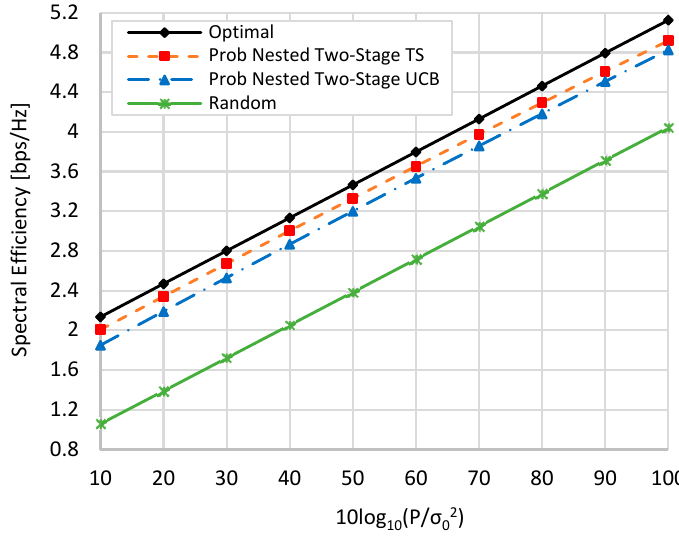
Figure 7. Spectral efficiency against TX SNR when N = 36 , M = 64 , and K = 16 at zero blockage.